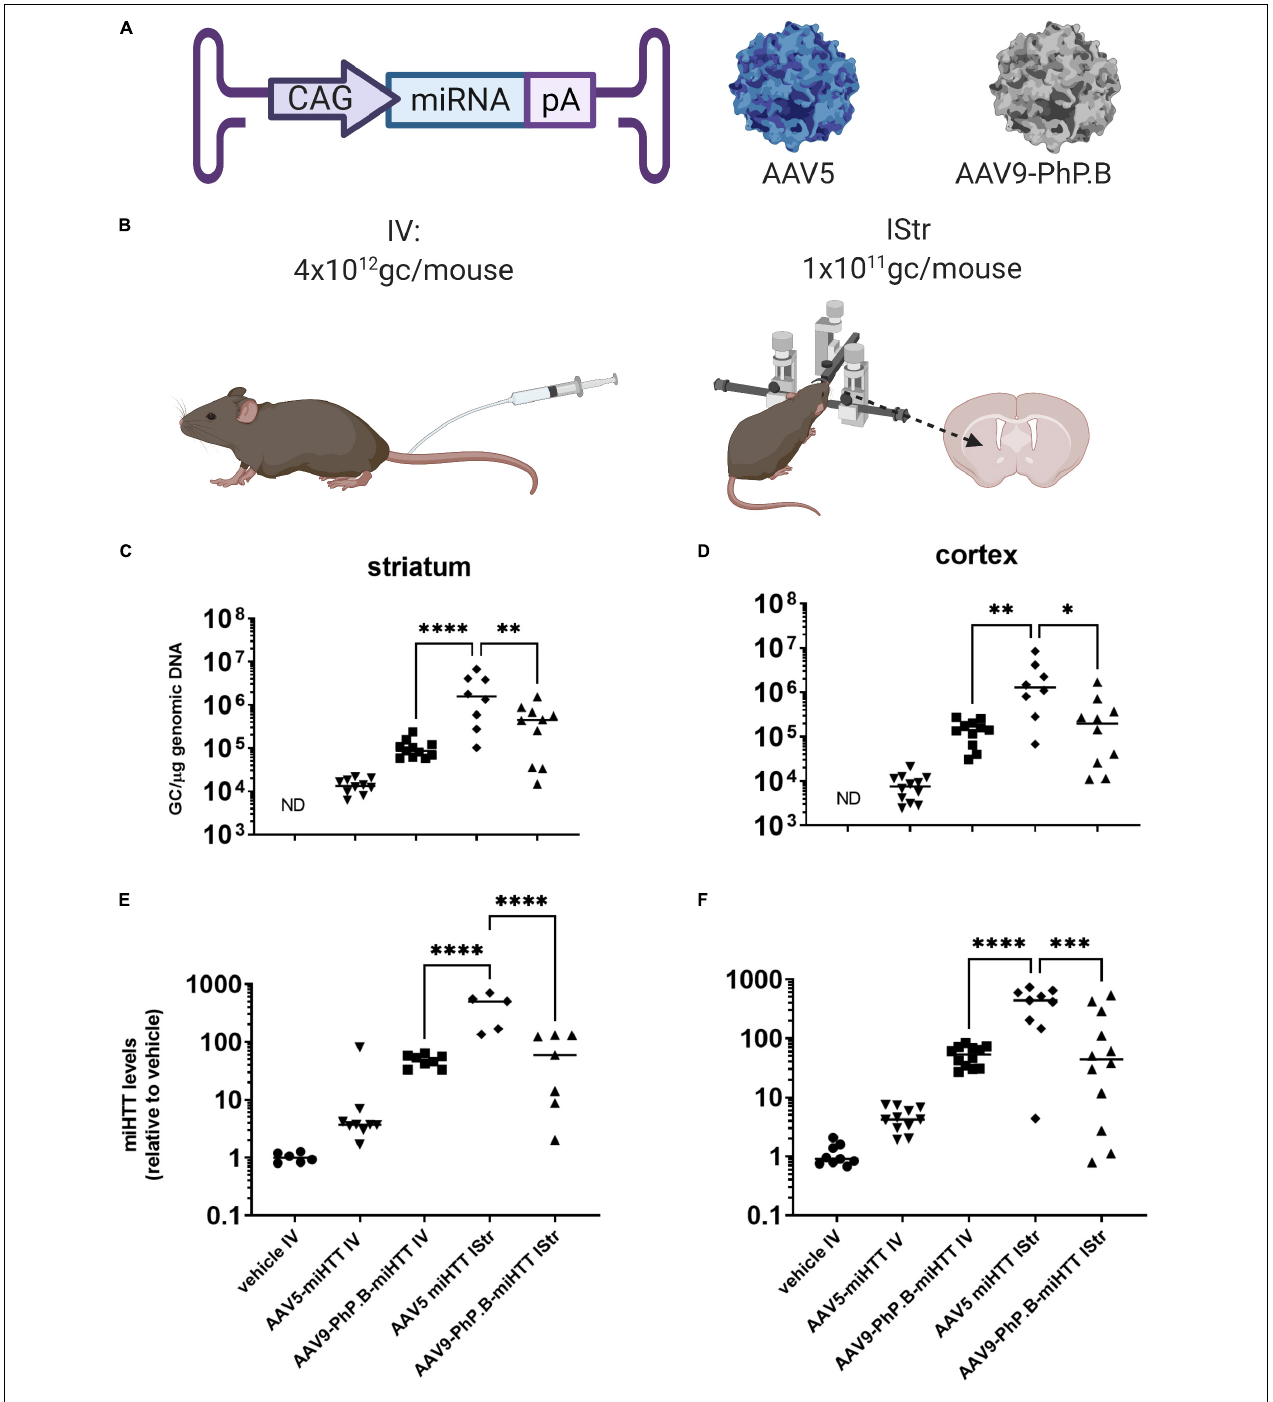
FIGURE 5 | Vector distribution and miRNA expression in mice brain after IV or intrastriatal (IStr) delivery. (A) A graphical representation of vectors used in this study. The expression cassette used consisted of CAG-promoter-miRNA and poly(A) tail. (B) Administration routes at which mice were either administered intravenously (IV) or IStr. (C) Distribution in the striatum. A significantly higher amount of vector DNA was observed in the striatum and cortex of mice that received AAV5 IStr. For AAV5, direct administration results in significantly higher distribution, while for AAV9-PhP.B, similar amounts of the vector were retrieved on average. (D) Distribution in the cortex. In the cortex, the same pattern is observed as in the striatum. The IStr administration of AAV5 results in higher amounts of vector DNA than the IV administration of AAV9-PhP.B or AAV5 IV. (E) miRNA levels in the striatum and (F) miRNA levels in cortex. The vector DNA results translate to miRNA expression levels. In this study, we also observed higher miRNA levels in mice administered AAV5 IStr compared with AAV9-PhP.B IV and AAV5-PhP.B. ND stands for not detected. Statistical analysis was performed by the one-way ANOVA, followed by the Bonferroni multiple comparisons test. Asterisks indicate a statistical significance of ∗ p ≤ 0.05, ∗∗ p < 0.005, ∗∗∗ p ≤ 0.001, and ∗∗∗∗ p <